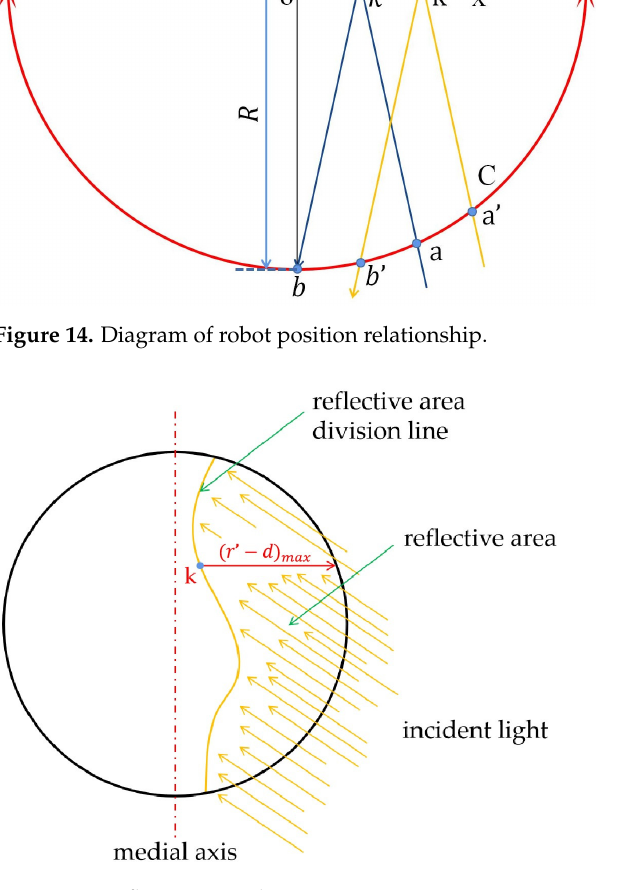
Figure 14. Diagram of robot position relationship.